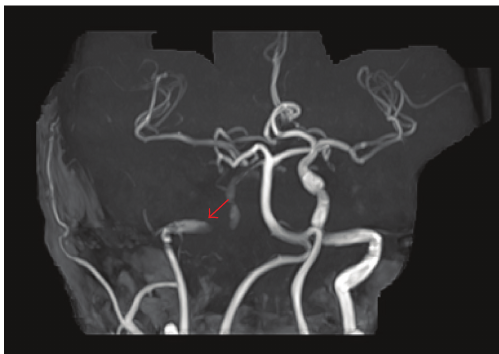
Figure 6: Reduced flow in the right MCA with a cross flow from the left hemisphere.